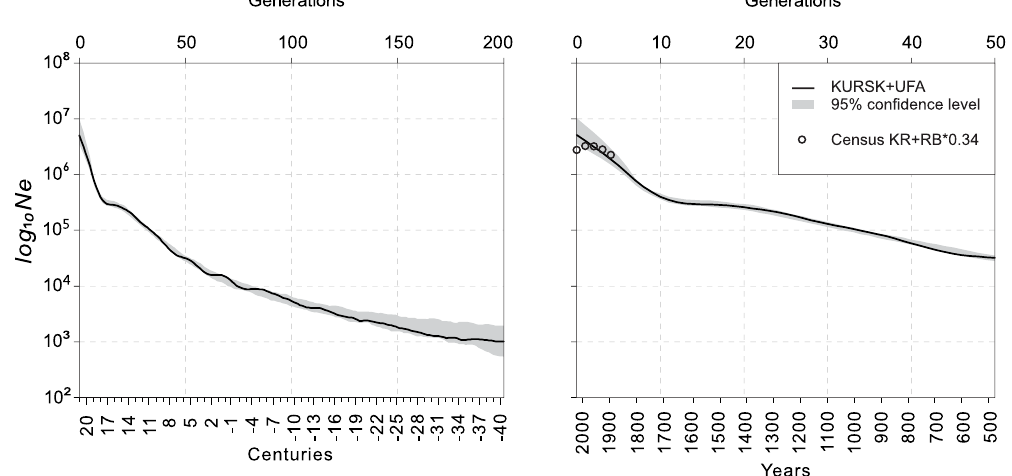
Figure 4. The recent effective population size of the ethnic Russians in the merged dataset from the KURSK and UFA